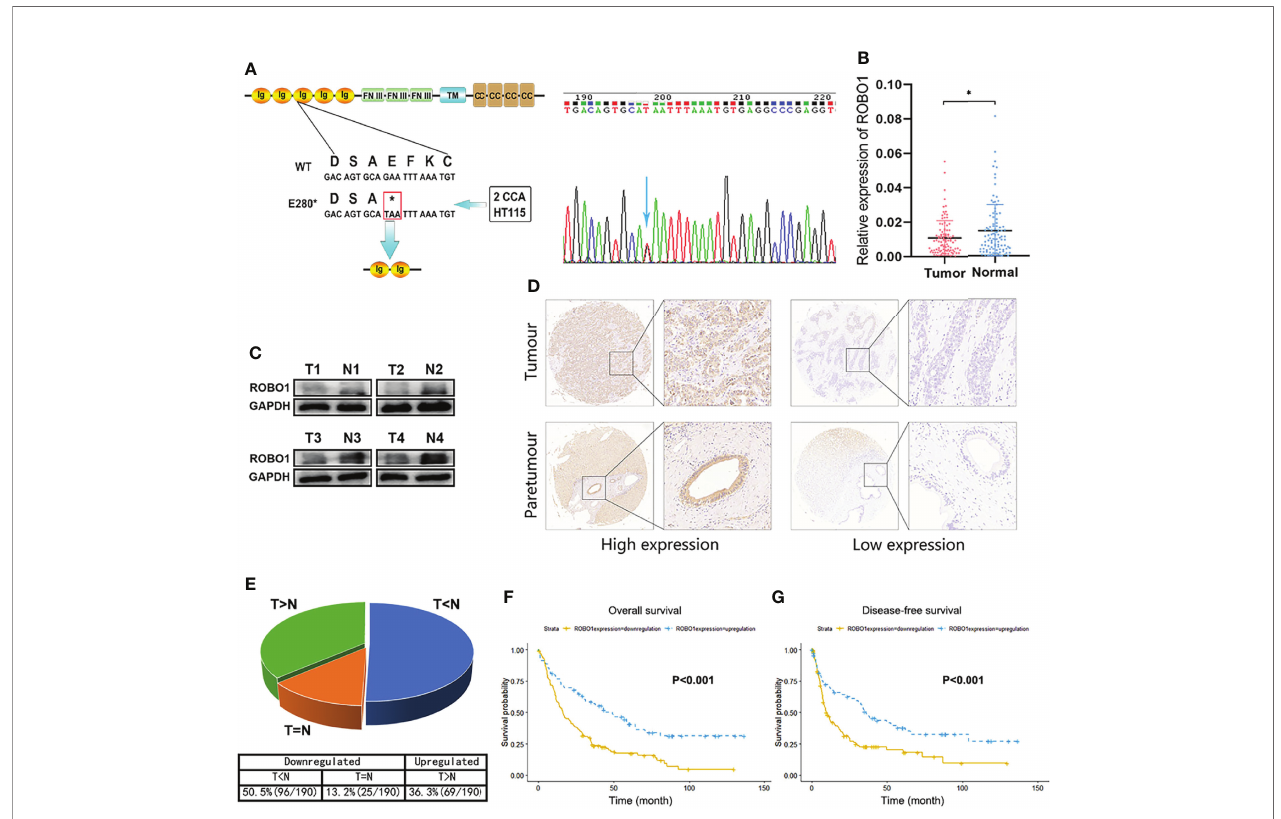
FIGURE 1 | The downregulation of ROBO1 in cholangiocarcinoma (CCA) was associated with poor survival. (A) ROBO1 p.E280* mutation in CCA tissues. (B) RT-qPCR analysis of ROBO1 expression in CCA tissues and adjacent normal tissues. ROBO1 was downregulated in CCA tissues. (C) Western blotting analysis of typical ROBO1 expression in CCA tissues and adjacent normal tissues. (D, E) Immunohistochemistry of tissue microarrays showing the expression of ROB O1 as downregulated in CCA tissues. (F, G) The downregulation of ROBO1 in CCA was correlated with poor overall survival and disease-free survival after surgery. * P <